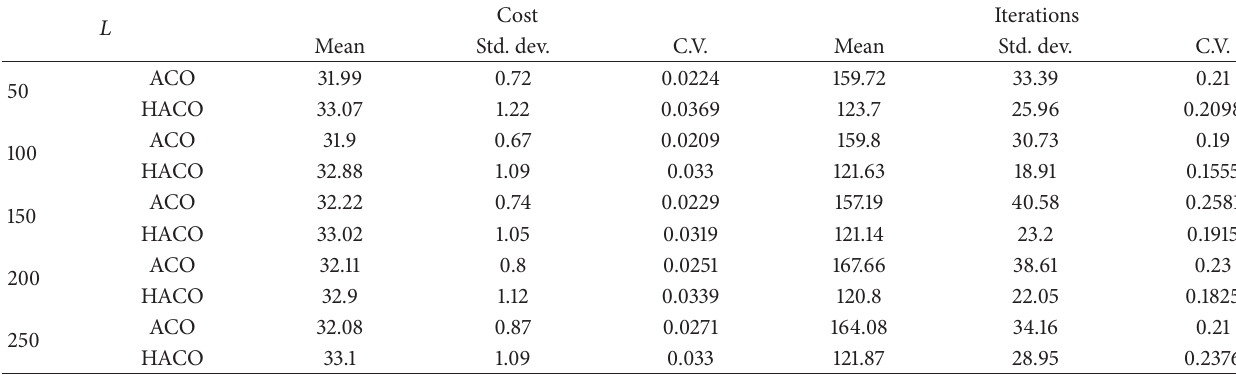
Table 5: Results with different L (cost: million CNY; iterations: times).